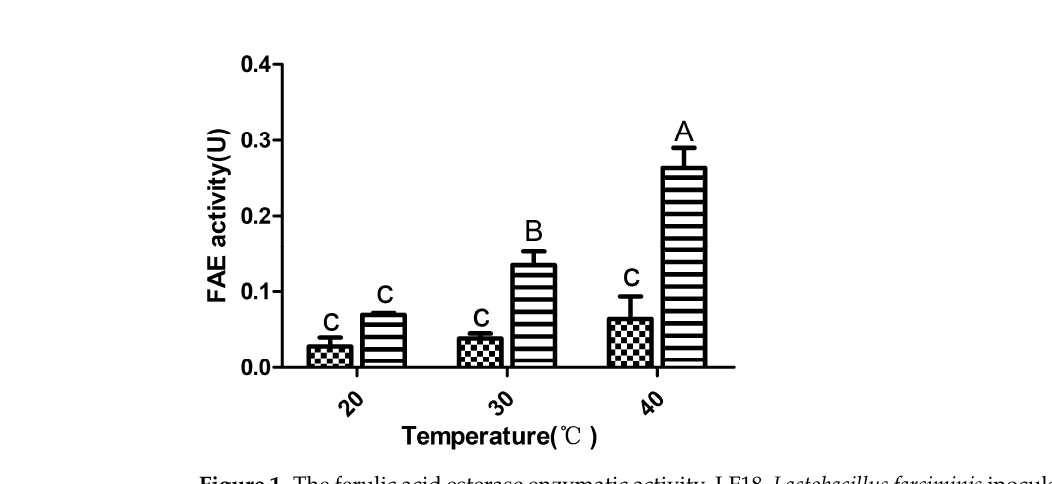
Figure 1. The ferulic acid esterase enzymatic activity. LF18, Lactobacillus farciminis inoculant ; LP23, Lactobacillus plantarum inoculant ; FAE, ferulic acid esterase. Means with difference superscripts (A–C) differ significantly from each other ( p < 0.05). Error bars indicate standard error of means.